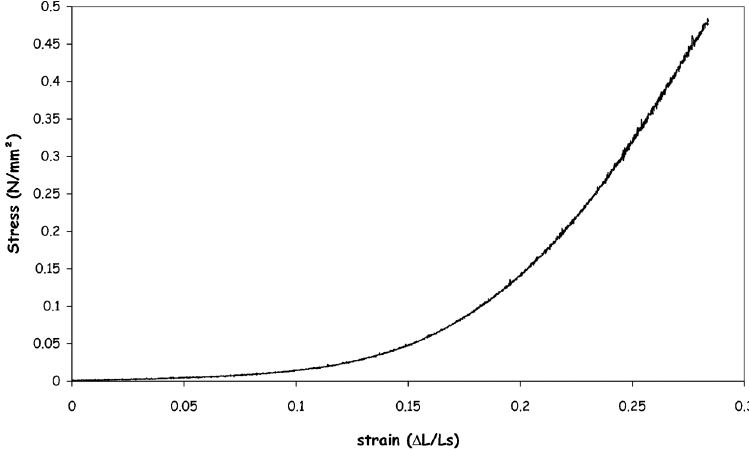
Figure 2 - Typical stress–strain curve obtained from the stretch–release